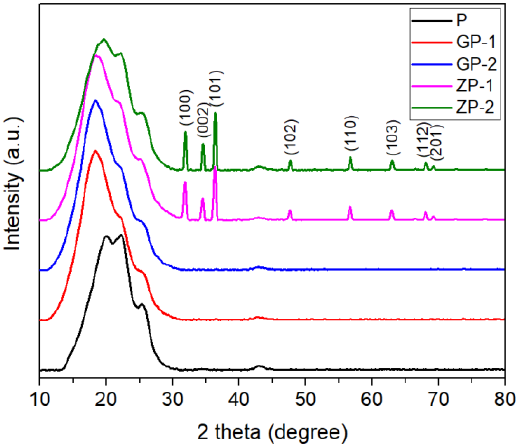
Figure 5. XRD graphs of fabricated membranes.